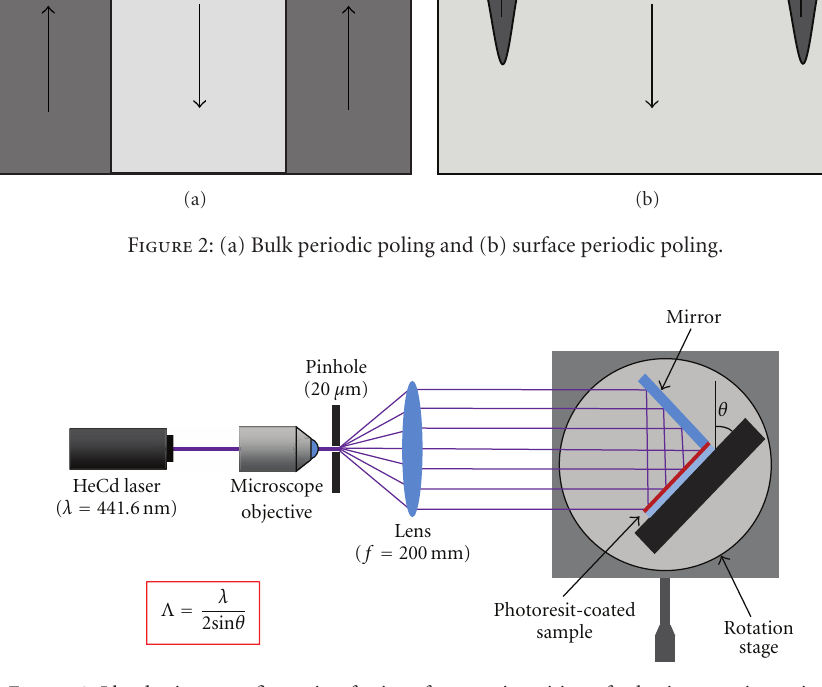
Figure 3: Lloyd mirror configuration for interferometric writing of submicrometric gratings.